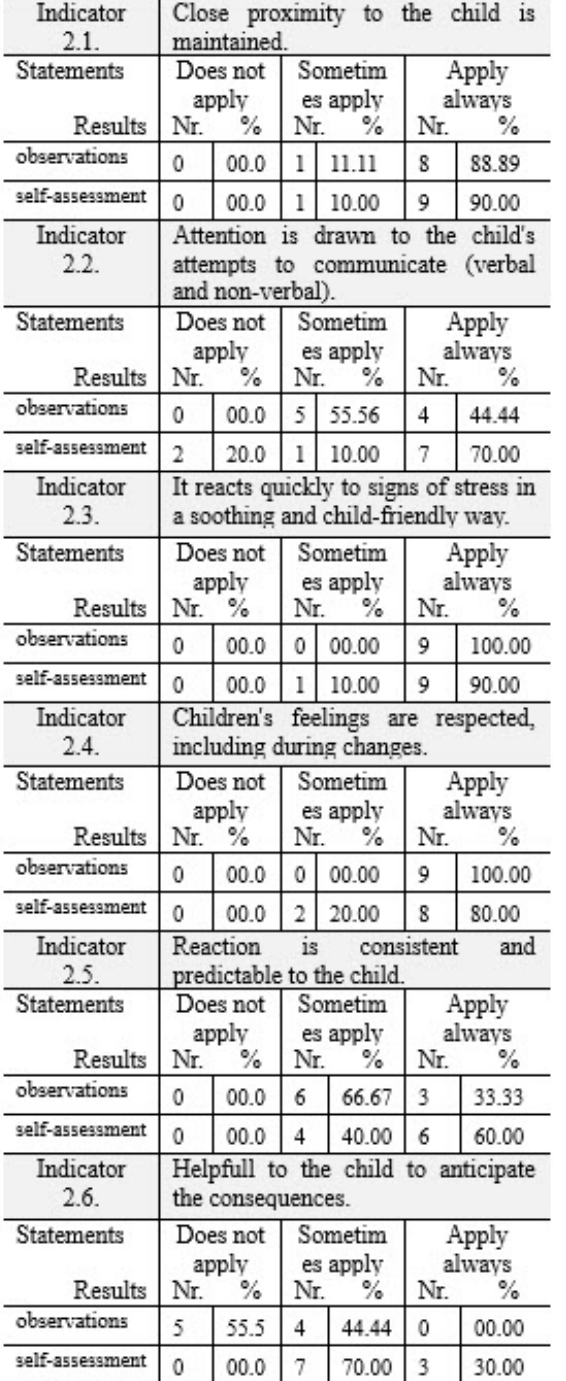
Table 3. Principle 3: Relationships are promoted through strategies that promote dia -